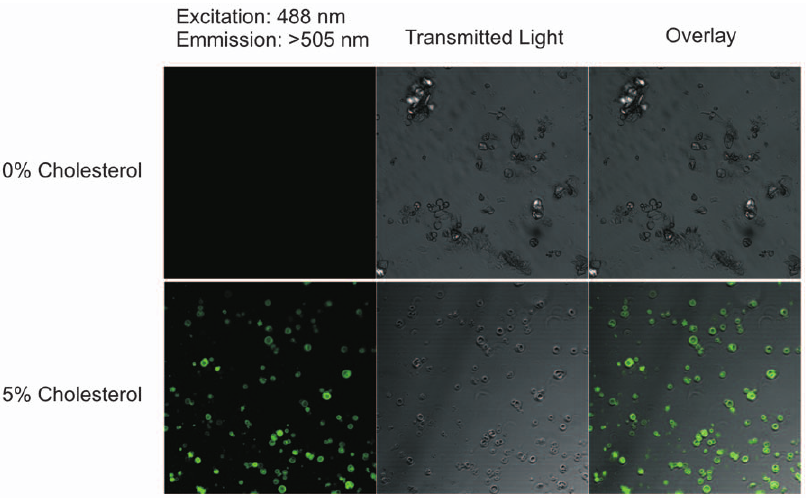
Figure 3. Cholesterol is present in giant liposomes. Giant liposomes were made with 3:1 POPE:POPG and 0% or 5% NBD-Cholesterol. Giant liposomes formed without NBD-cholesterol showed no emission above 505 nm following excitation at 488 nm. Robust fluorescence was observed for giant liposomes made in the presence of 5% NBD-cholesterol.